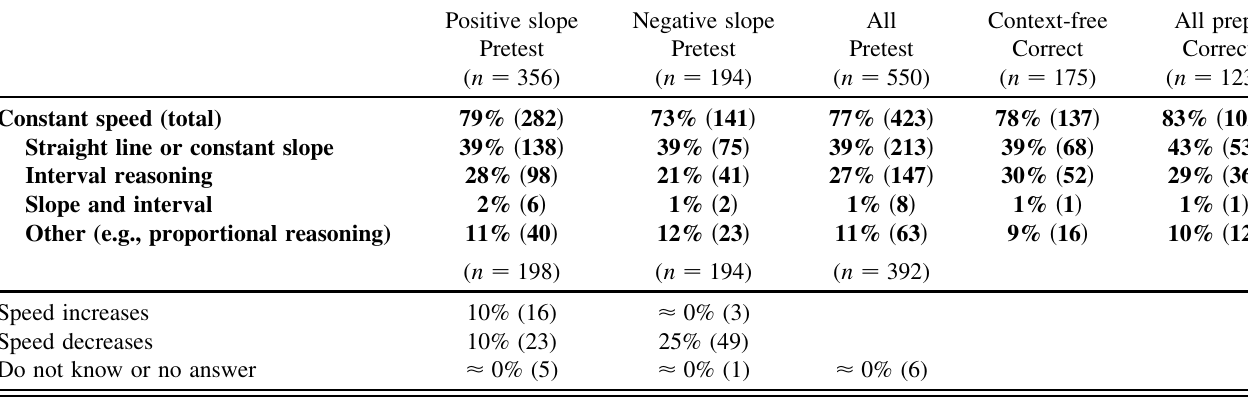
TABLE I. Pretest results for the question of whether the speed of the ball is increasing, decreasing, or constant. Correct answers (constant speed) are categorized by reason (straight line or constant slope or interval reasoning, both or other). The first numerical column gives percentages of the 356 students who took a pretest involving a graph with positive slope; likewise the second numerical column for negatively sloped graphs, and the third column for all students combined. The fourth numerical column shows percentages only for students who took the y; x graph pretest as well as the distance-time graphs and answered it correctly. The fifth column shows percentages only for students who also correctly determined the direction of motion. Note that in many, but not all sets of questions, students were also asked to state whether the speed was increasing or decreasing. This information is given in the bottom part of the table. In all tables, correct answers are printed in bold. Positive slope Negative slope All Context-free All prep Pretest Pretest Pretest Correct Correct ( n ¼ 356 ) ( n ¼ 194 ) ( n ¼ 550 ) ( n ¼ 175 ) Constant speed (total)